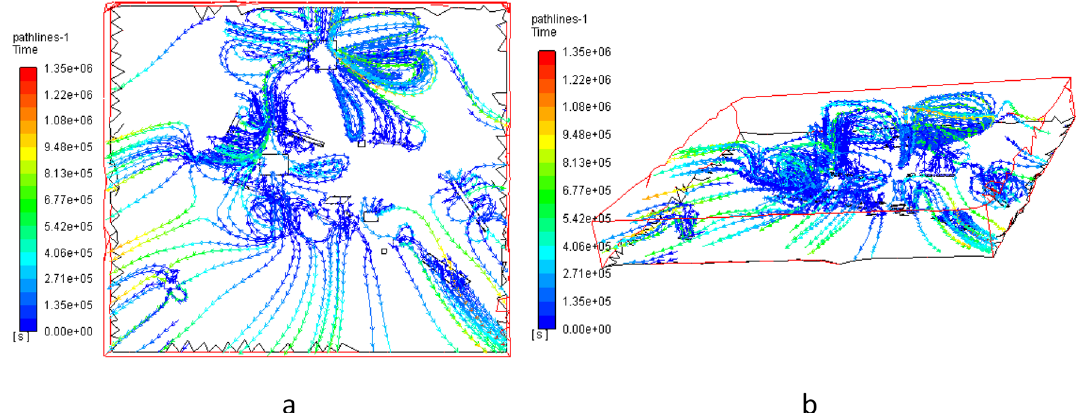
Figure 6. Dust particles migration path under windless wind by Fluent